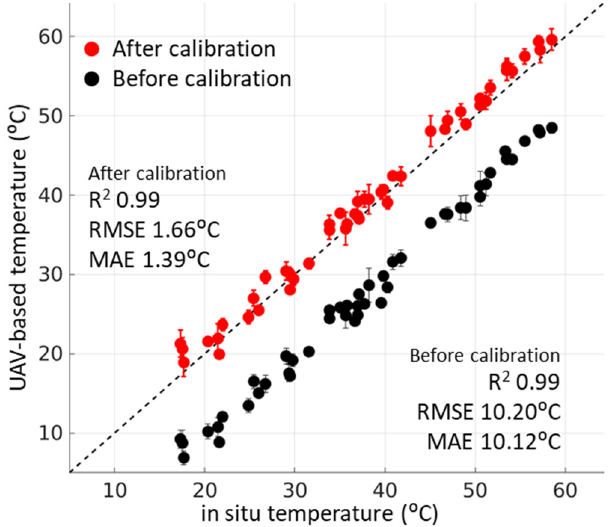
Figure 6. Scatterplot showing the relationship of the in situ temperature measurements derived with